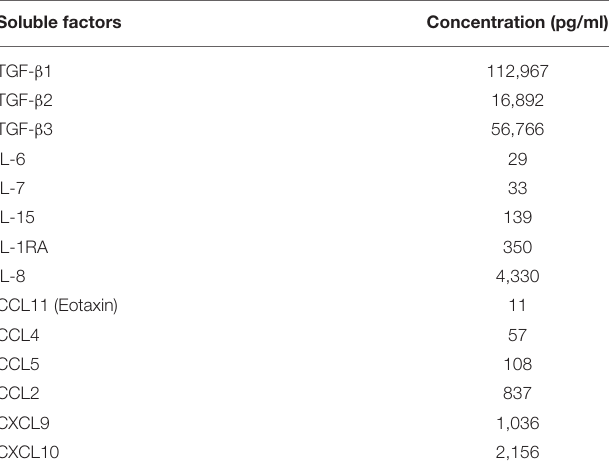
TABLE 1 | Cytokine and chemokine composition of the SP